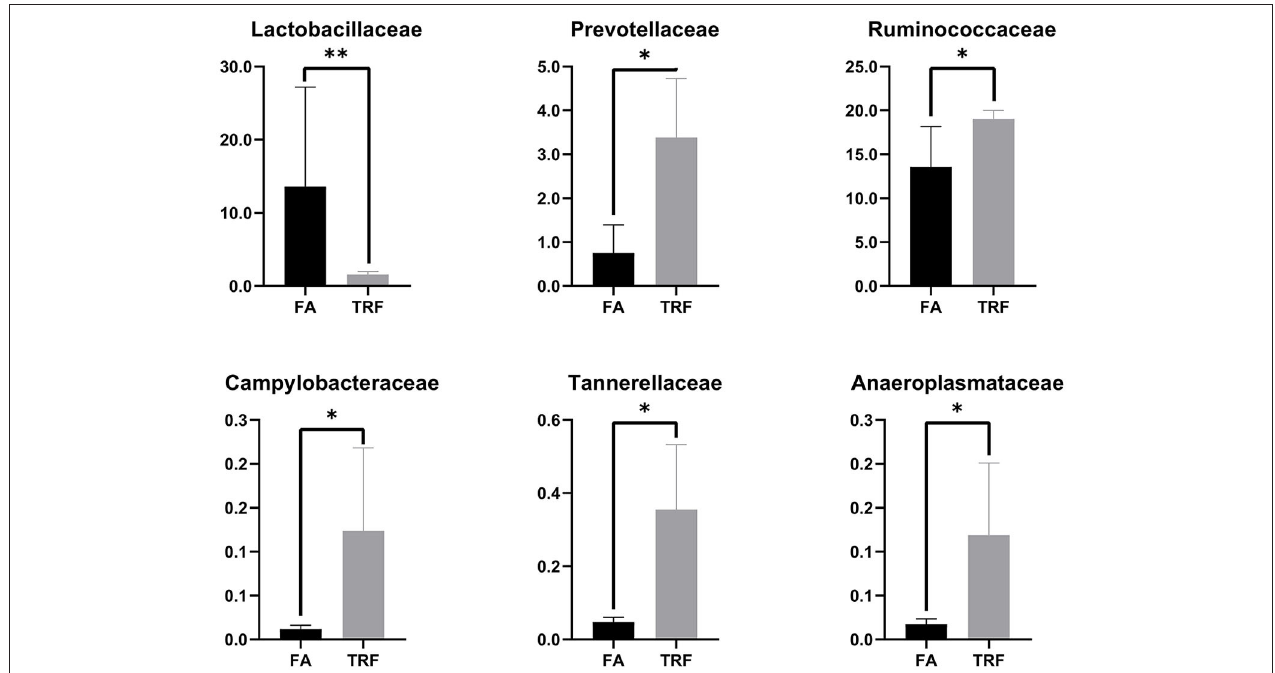
FIGURE 2 | The relative abundance of bacteria in colonic digesta of growing pigs at the family level. FA, free access group; TRF, time-restricted feeding group. **Indicates a significant difference between the FA and TRF groups with P < 0.01; while *indicates a significant difference with P < 0.05.